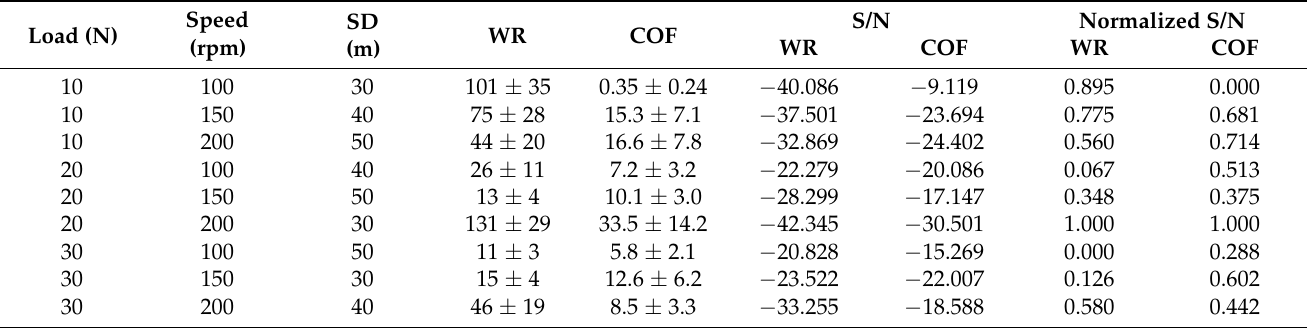
Table 3. Data from wear tests and signal-to-noise ratio (absolute and